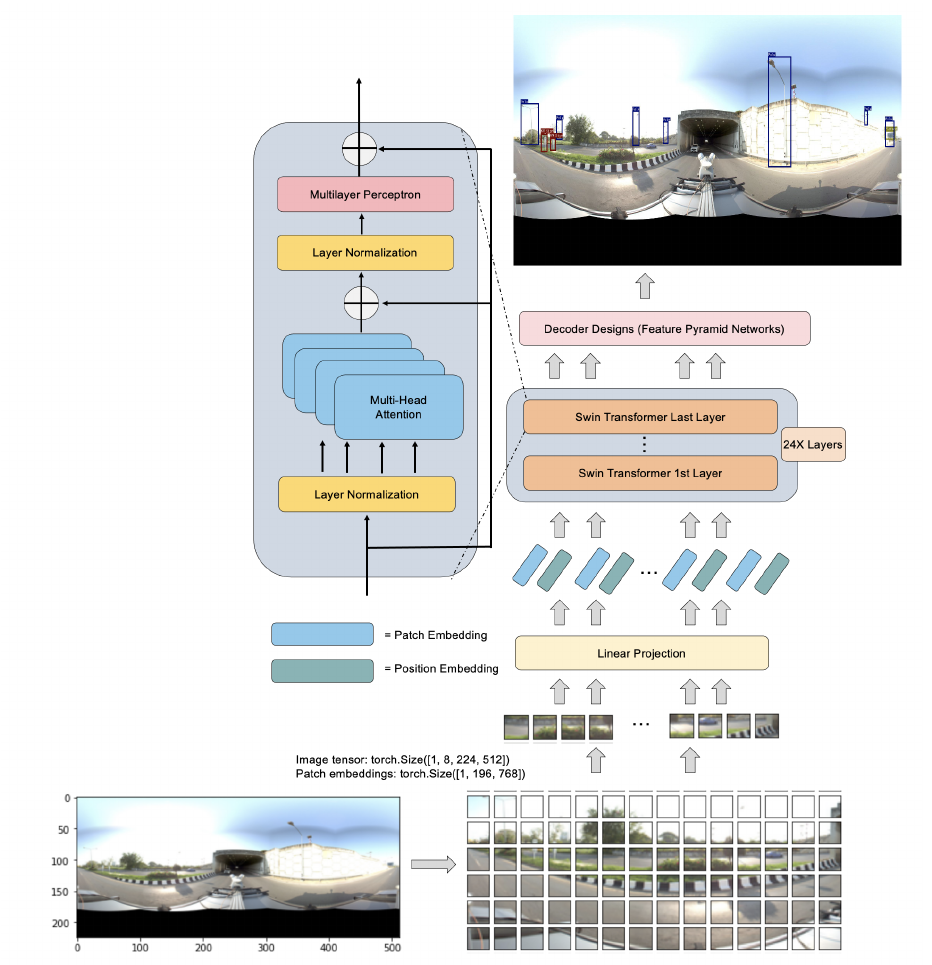
Figure 4. Overall architecture of our Transformer-Based YOLOX.